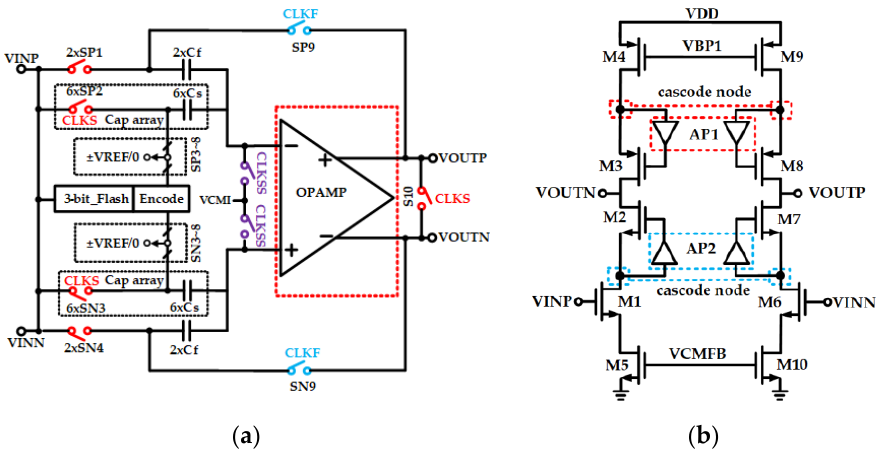
Figure 9. ( a ) A fully differential 2.5-bit flip-around MDAC. The operational amplifier gain is equal to 4. The sampling switch is bootstrapped. ( b ) Operational amplifier schematic. Both the NMOS and PMOS sides are cascaded. AP1 and AP2 are auxiliary op-amps, added to improve gain.